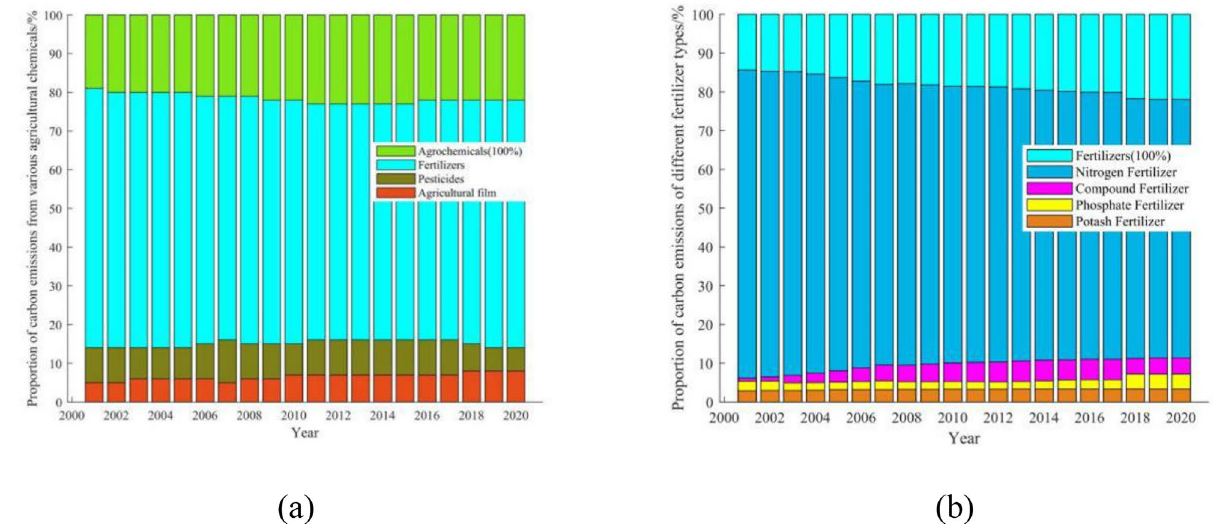
Figure 2. ( a ) Proportion of carbon emissions from various types of agricultural chemicals in Guangdong farmland ecosystems; ( b ) proportion of carbon emissions from different fertilizer types in Guangdong farmland